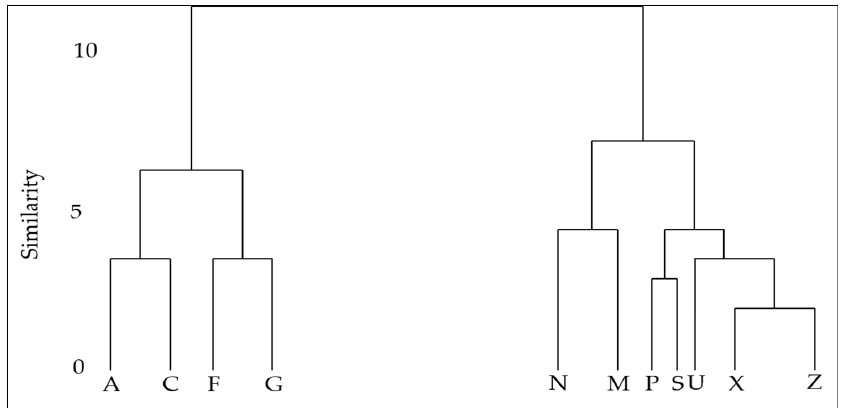
Figure 2. A graphical illustration of the dendrogram, where clusters at one level are joined together to form the clusters at the next levels.